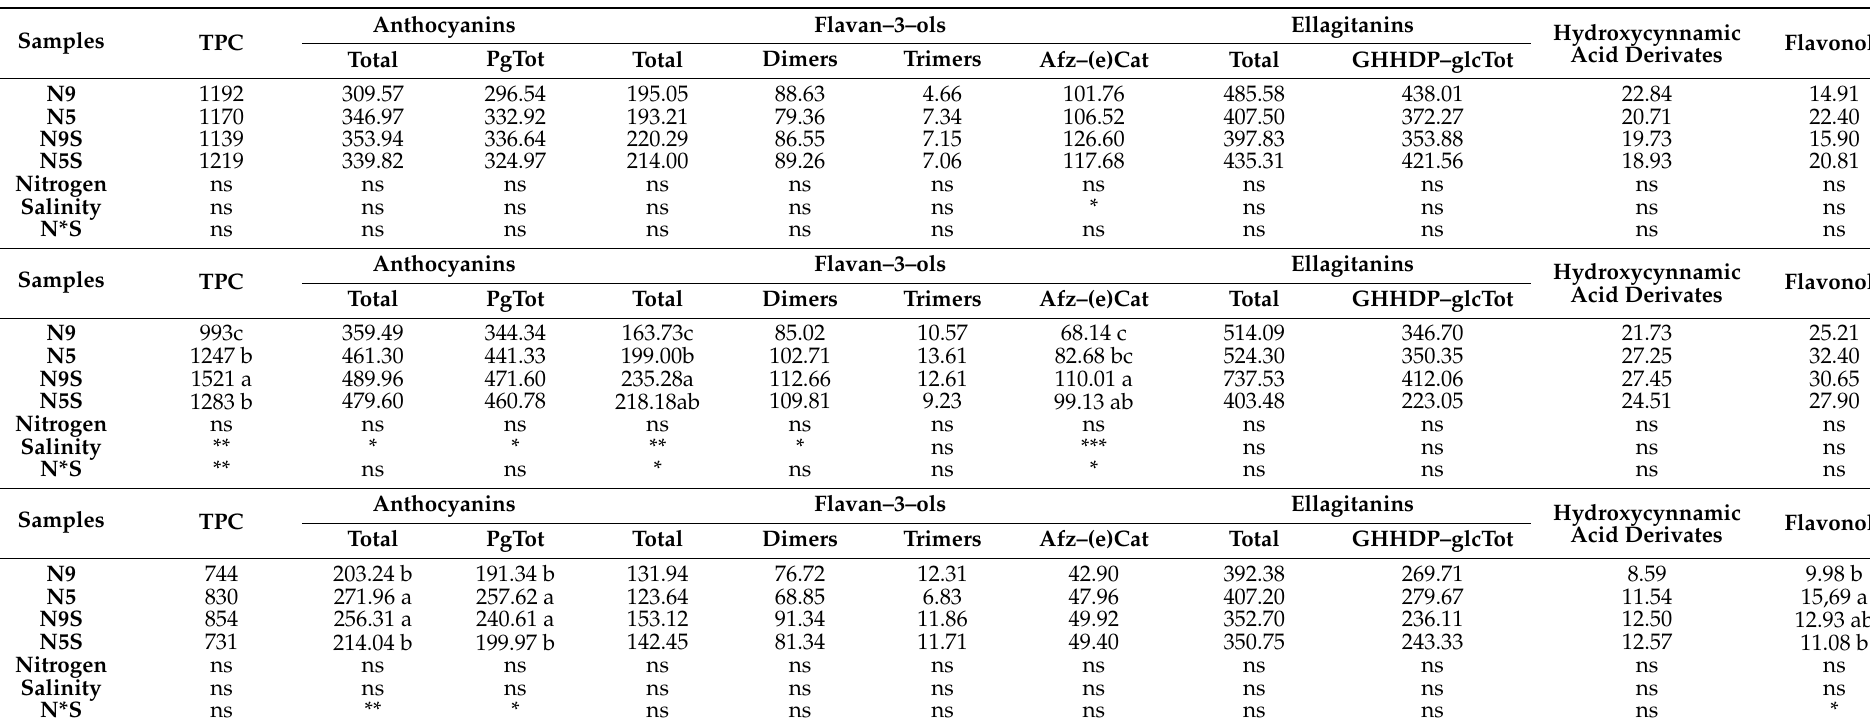
Table 3. Effect of variables on the sums of compounds pertaining to each polyphenol subclass. Concentrations are expressed in mg/100 g of dried weight a